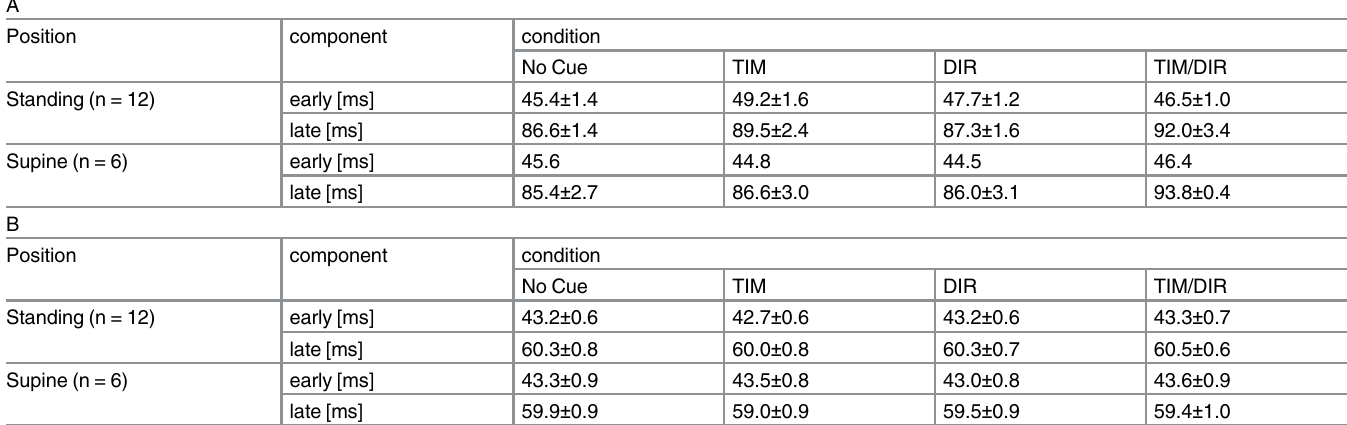
Table 1. Latencies of early and late responses while standing and in the supine position among the different cue